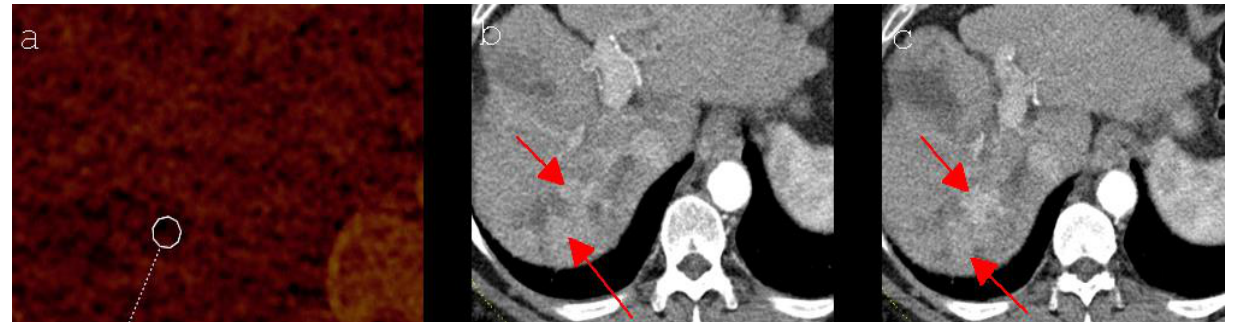
Figure 2. ( a ) Axial DECT imaging (iodine mapping) shows an ablation zone in segment VII of a 66-year-old man 24 h after MWA of a HCC, including the chosen regions of interest in its peripheral part. ( b , c ) Axial CT imaging (arterial phase) shows an arterial hypercasvular tumor mass (red arrows) in the peripheral part of the ablated area, which newly occurred at the 12 months follow-up control and turned out to be LTP of a HCC.